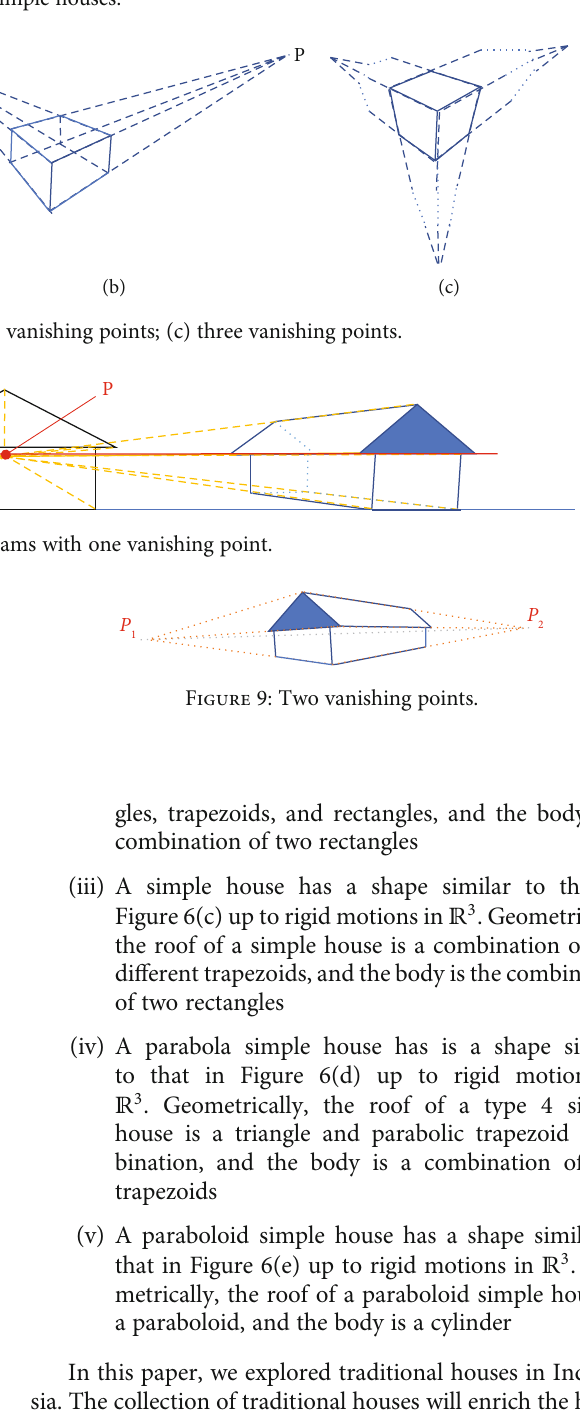
Figure 6: Simple houses.